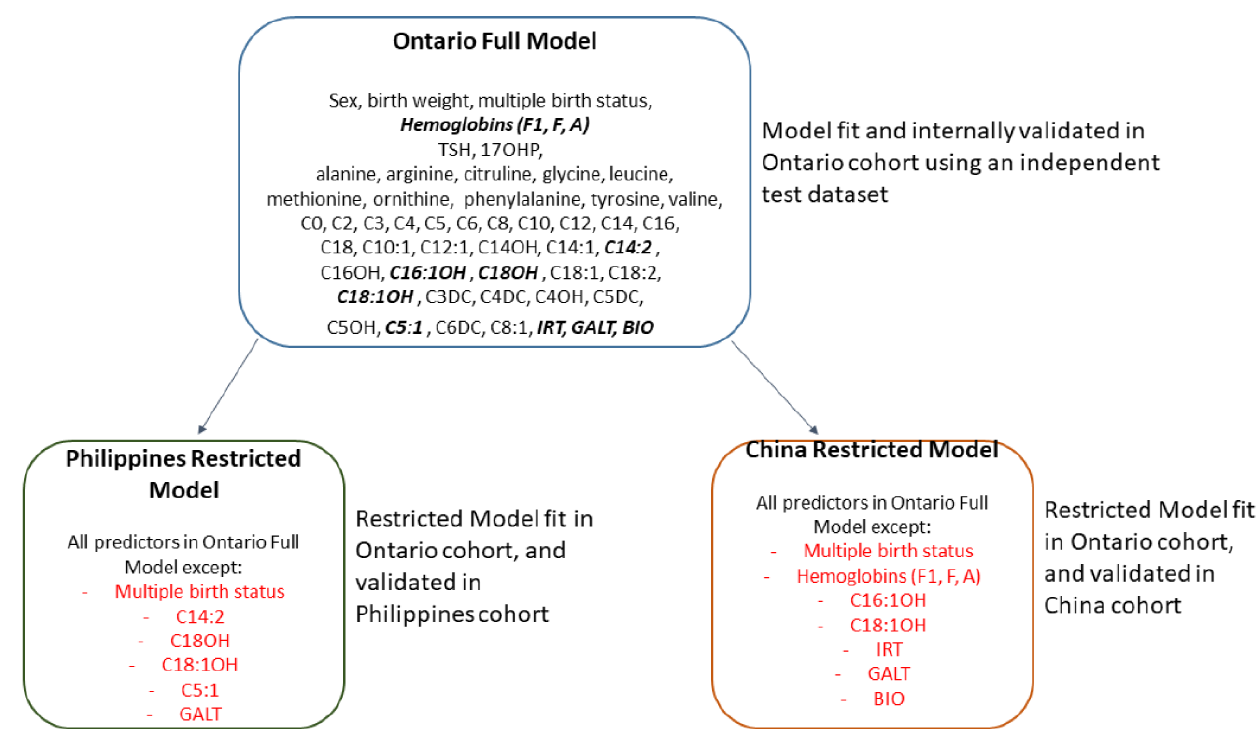
Figure 1. Full model vs restricted